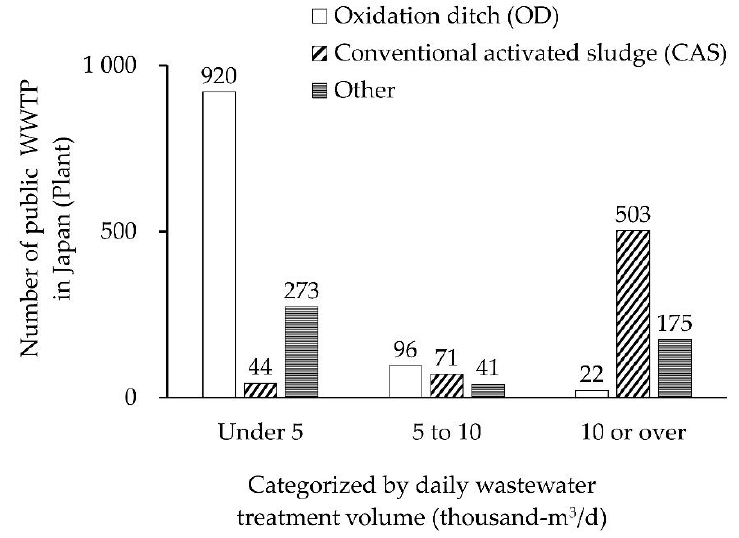
Figure 1. Number of wastewater treatment plants (WWTPs) in Japan categorized by daily treatment volume (m 3 /d) [7].